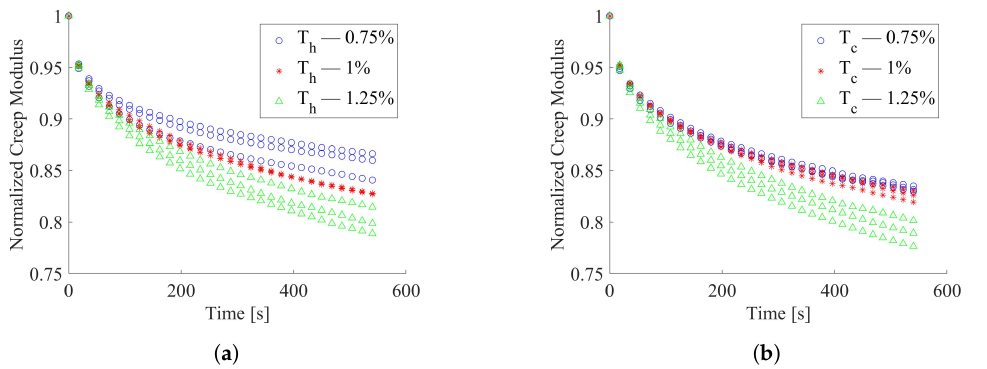
Figure 6. Normalized creep modulus over time for thermally conditioned 0° specimens; ( a ) Thermal conditioning T = 50 °C; ( b ) Thermal conditioning T = − 15